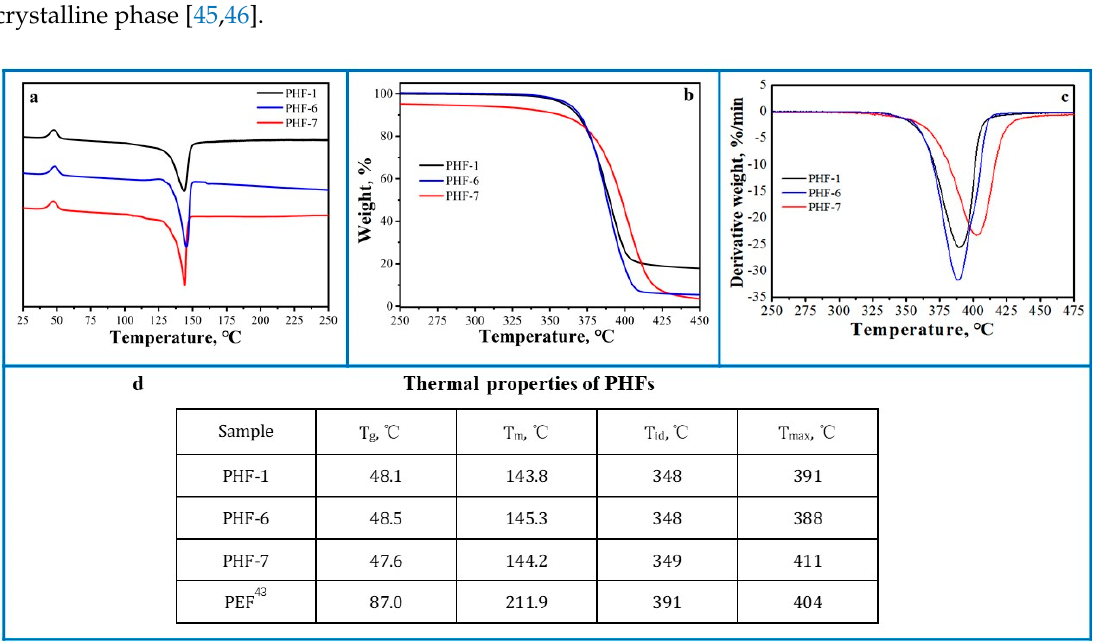
Figure 6. Thermal Properties of PHFs. ( a ) DSC curves; ( b ) TG-curves; ( c ) Derivative Thermogravimetry (DTG)-curves; and, ( d ) related thermal properties of PHFs at a scanning rate of 10